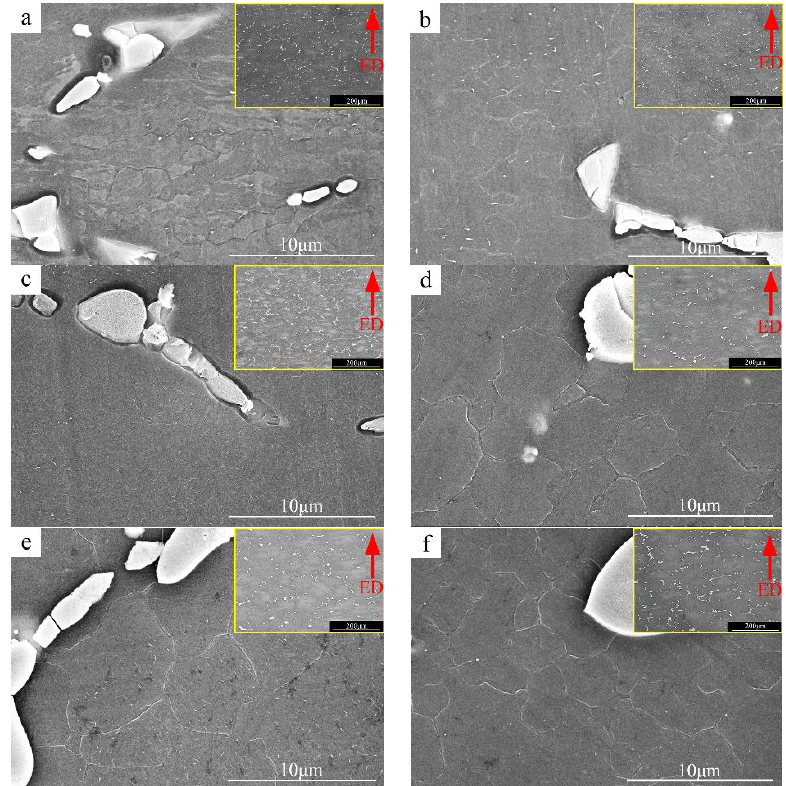
Figure 9. SEM microstructure image of deformed alloys. Red arrow direction is the extrusion direction (ED) ( a ) ZCI, ( b ) ZCII, ( c ) ZCIII0, ( d ) ZCIV, ( e ) ZCV, ( f ) ZCVI.